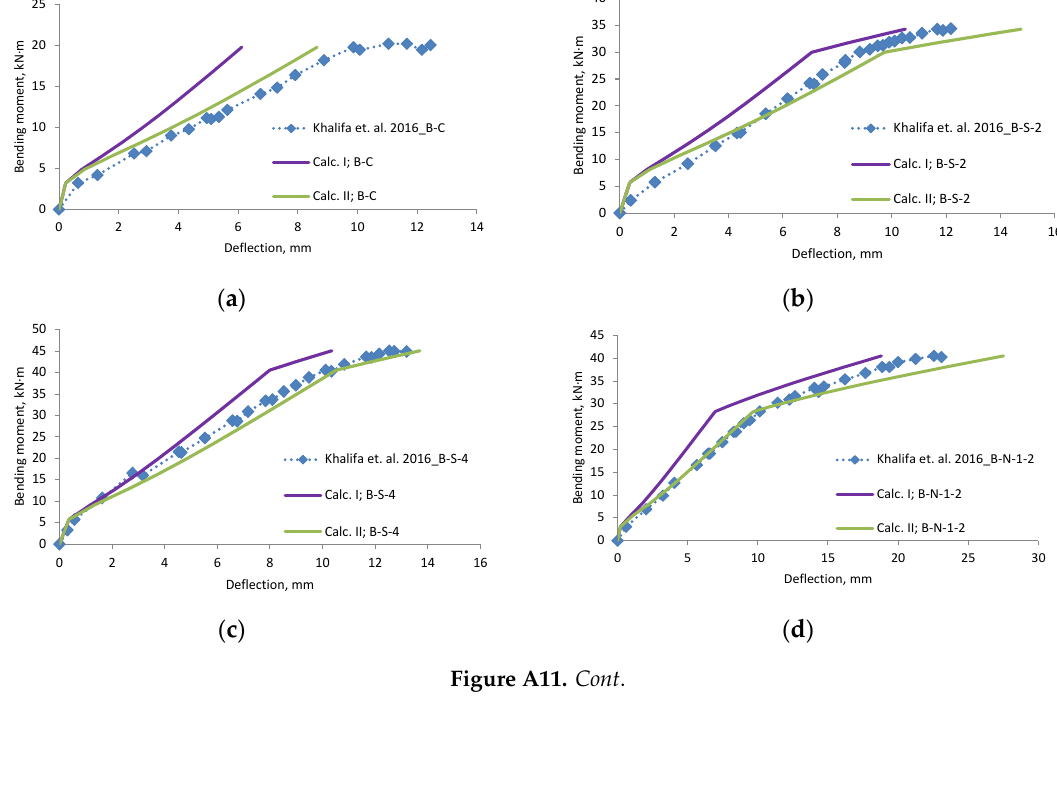
Figure A11. Cont